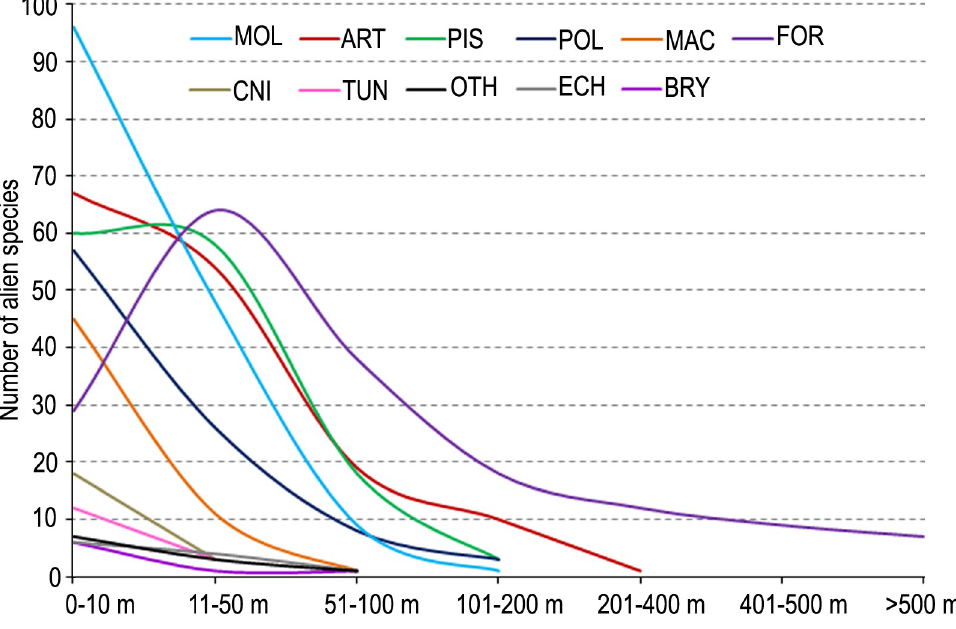
Fig 14. The number of alien species in major taxonomic groups found in the depth intervals.